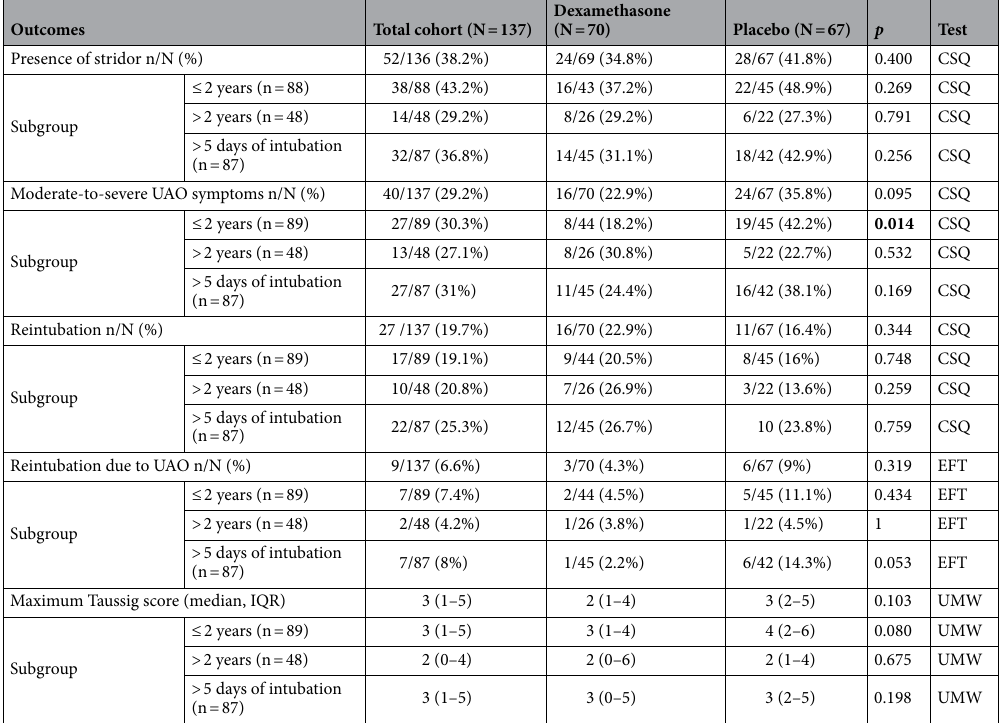
Table 2. Presence of stridor, moderate-severe UAO symptoms, reintubation incidence, reintubation due to UAO and maximum Taussig between treatment groups. Chi-squared test (CSQ), Exact Fisher Test (EFT), and U-Mann Whitney (UMW), test were used. Statistically significant values appear in bold.